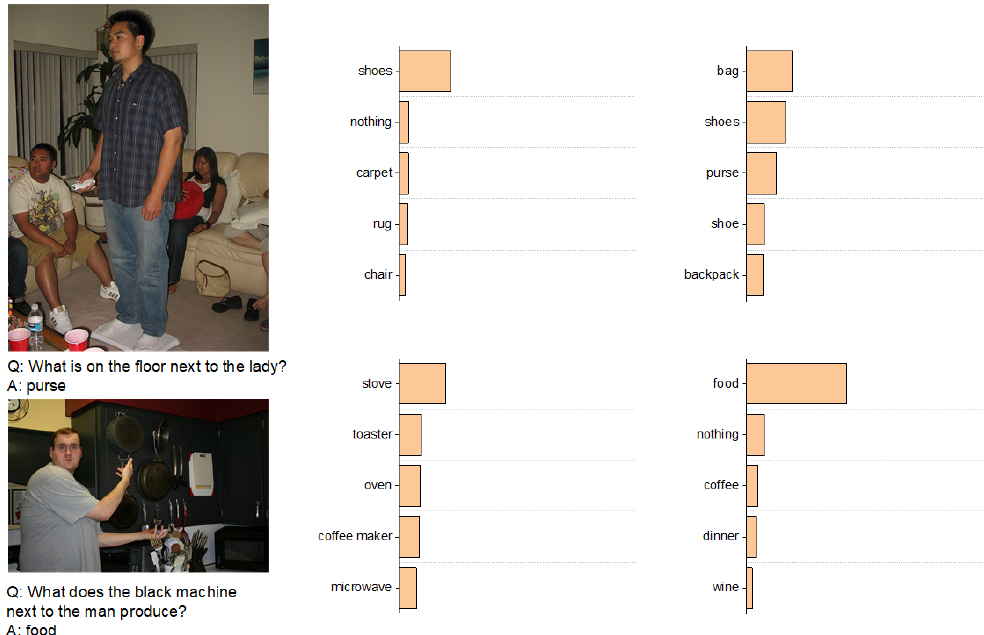
Figure 8. Examples of model prediction for complicated questions. The second column is the TOP5 prediction of the “-PA” model, and the third column is the TOP5 prediction of